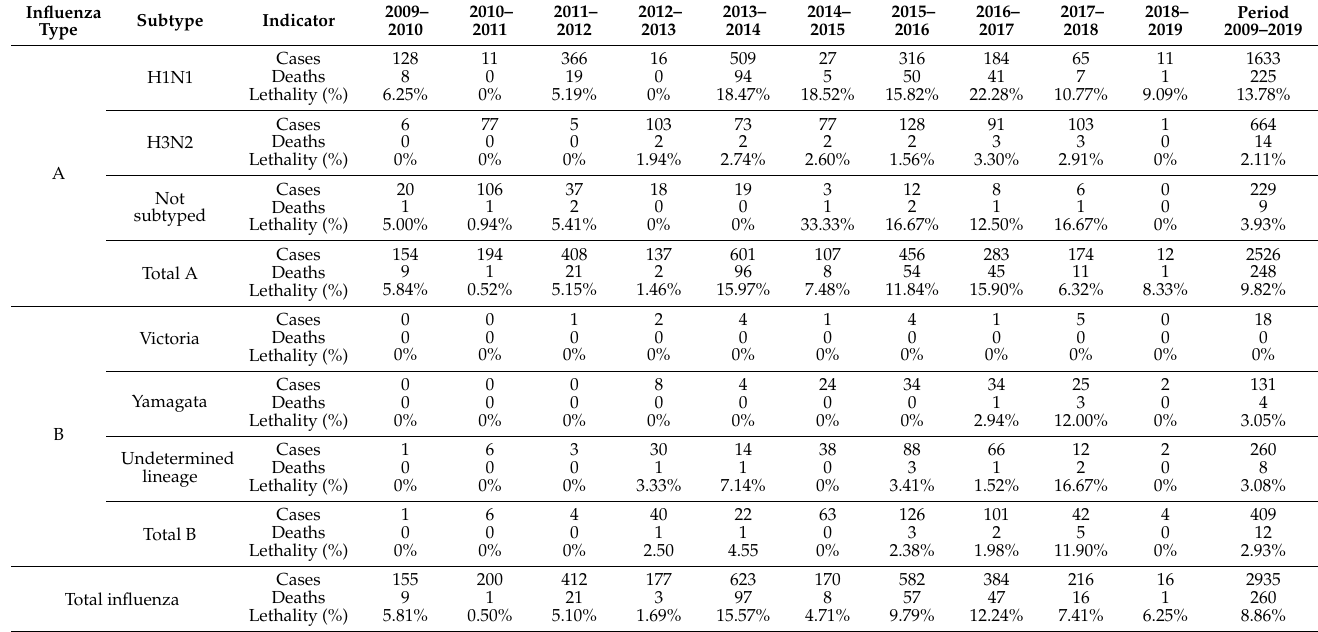
Table 3. Cases, deaths and lethality in the target population 1 by